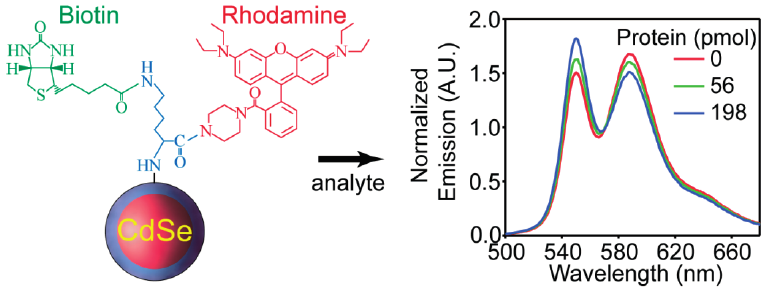
Figure 9. Schematic illustration of the protein sensor structure composed of the CdSe/ZnS QD conjugated with RB piperazine-lysine-biotin, and the ratiometric response of the sensor to streptavidin (reprinted with permission from [105], Copyright 2014 The American Chemical